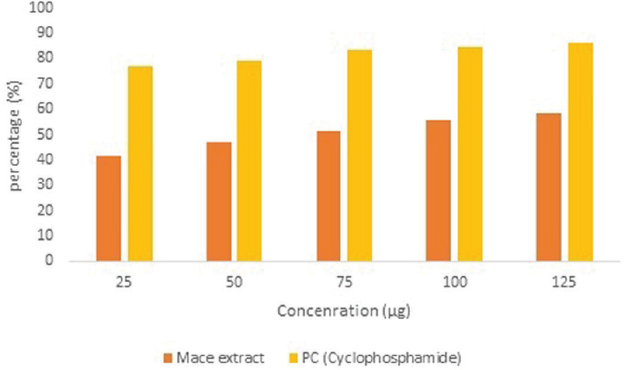
FIGURE 3 - The effect of Mace extract on morphology of KB cells. Cells were treated with vehicle (DMSO) or various doses of mace acetone extract (100 μg/mL for KB cells) for 24 h and 48 h. Cell viability was determined by photographs captured by phase contrast microscope at magnification,